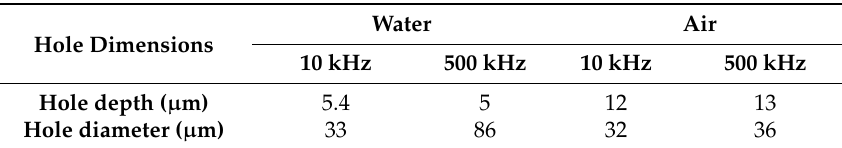
Table 1. Characteristics of holes drilled in industrial steel with 500 pulses.